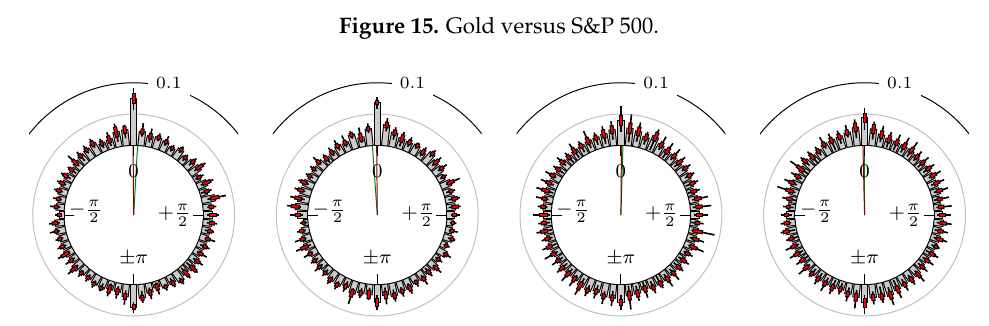
Figure 16. Gold versus DAX.